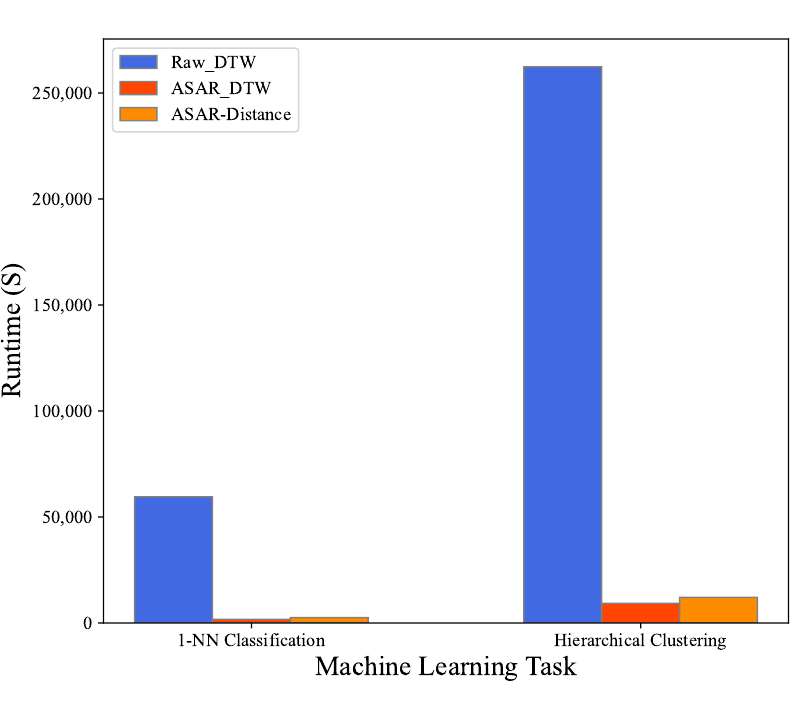
Figure 5. Classification and clustering runtimes for the raw and the ASAR form when using elastic measures (the DTW and